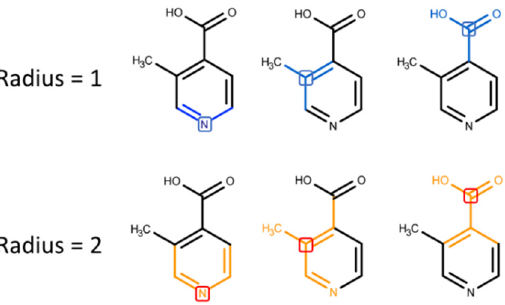
Figure 3. Molecular fragments encoded in FCFC fingerprints with different radii.